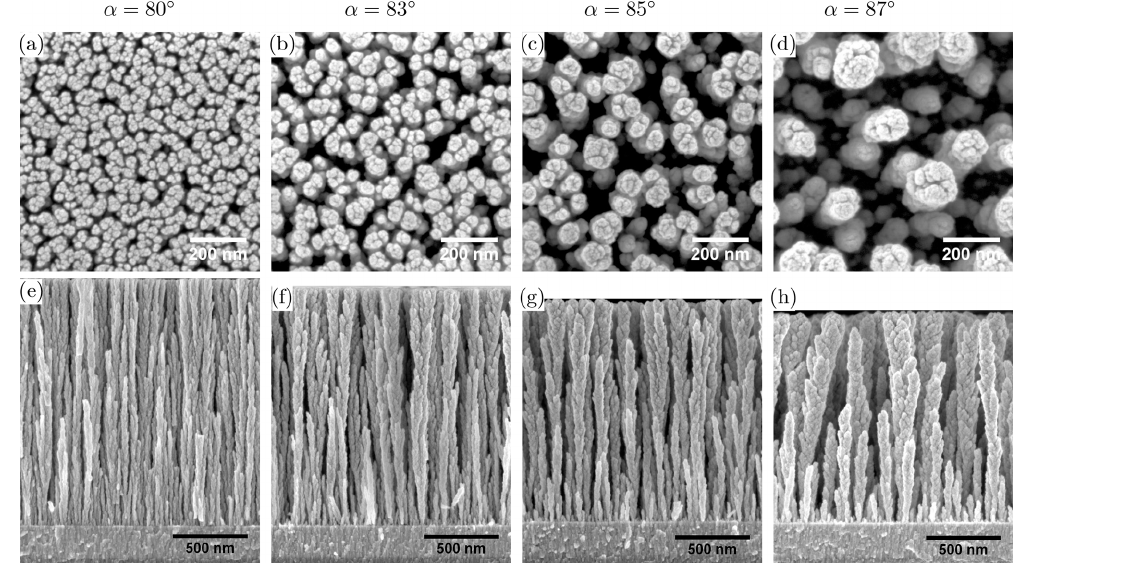
Figure 4. (a) – (d) SEM top view and (e) – (h) side view images of tantalum GLAD films deposited at P ω = 6 . 2nm per revolution and the labeled deposition angles to produce column structures. The top-view images serve as input for the Fourier analysis.